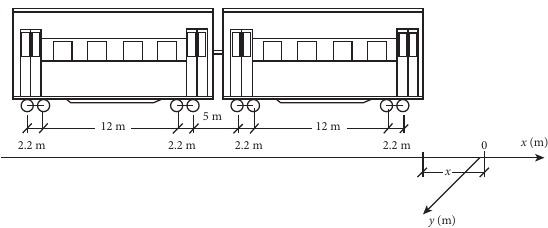
Figure 6: Schematic diagram of the vehicle model.